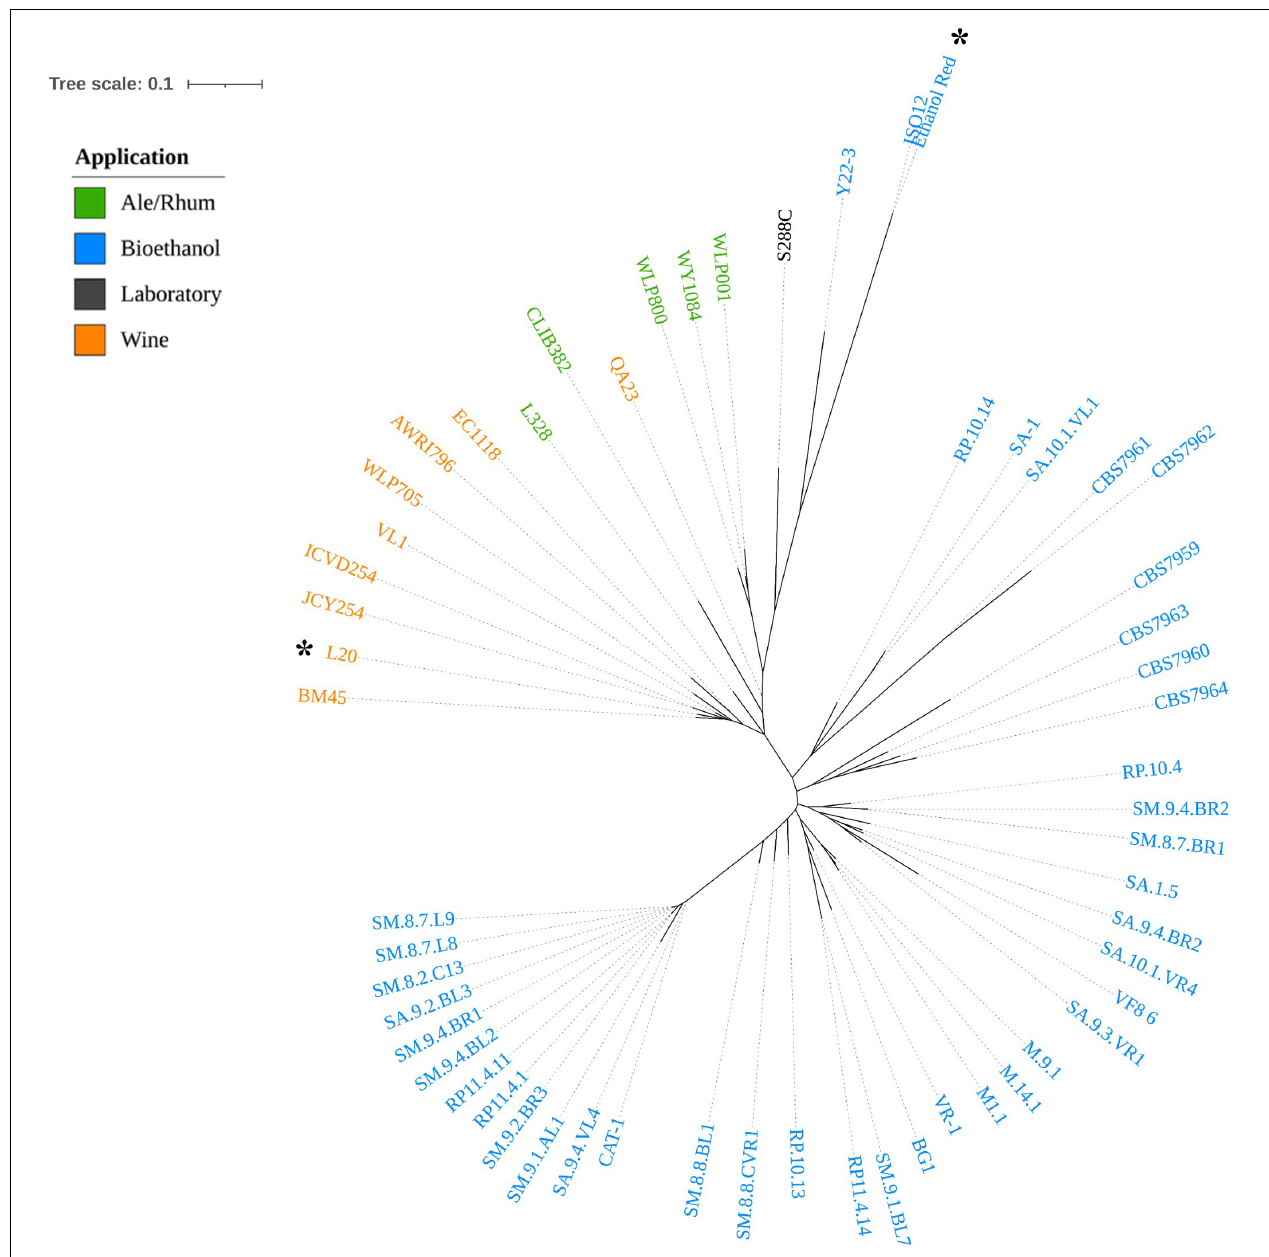
FIGURE 2 | A maximum-likelihood phylogenetic tree based on SNP dataset representing the genetic distances among the 56 S. cerevisiae strains. The L20 and Ethanol Red strains sequenced in this study are marked with a black asterisk. The colors depict the industrial application of each strain (orange: Wine; green: Ale/Rhum; black: Laboratory; blue: